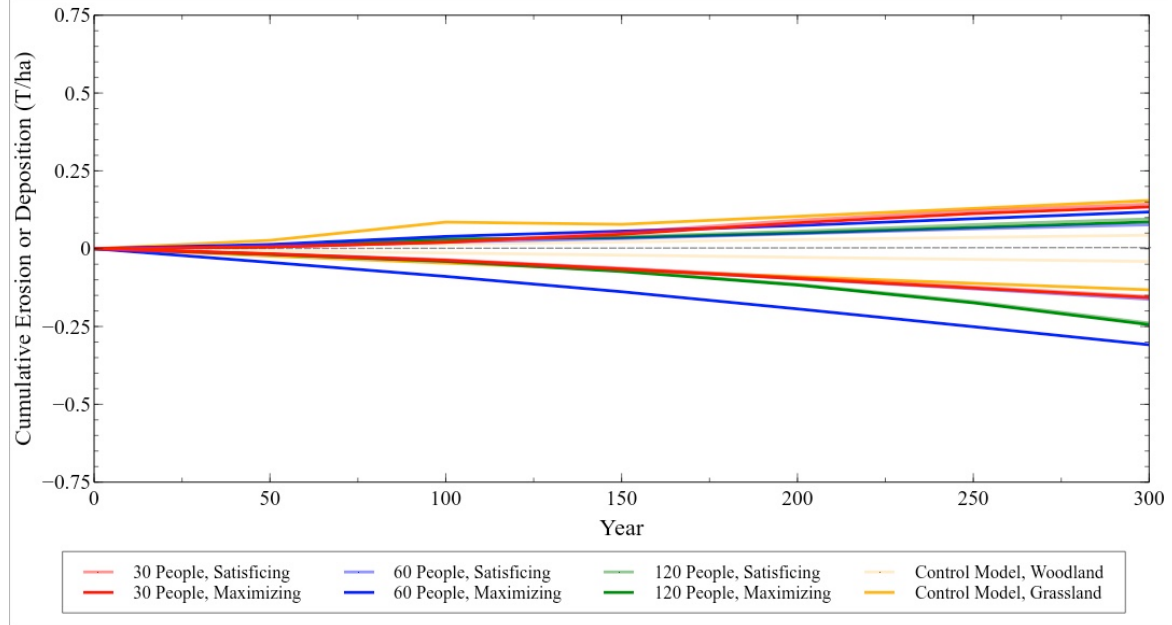
Figure 11. Cumulative amount of sediment eroded or deposited (tons/ha) in the delineated Mas d’Is farming catchment (see Figure 4) for each of the six experiments and two control runs during the 300-year modeling interval. Values are averaged across the 40 repetitions of each experiment. The cumulative tons/ha of eroded sediment are shown below the center lines of each graph, and cumulative tons/ha of deposited sediment are above the center lines for the 300 year modeling interval. We show erosion and deposition separately because sediment removal and accumulations often happen in different landscape contexts, with different consequences for agropastoral and other